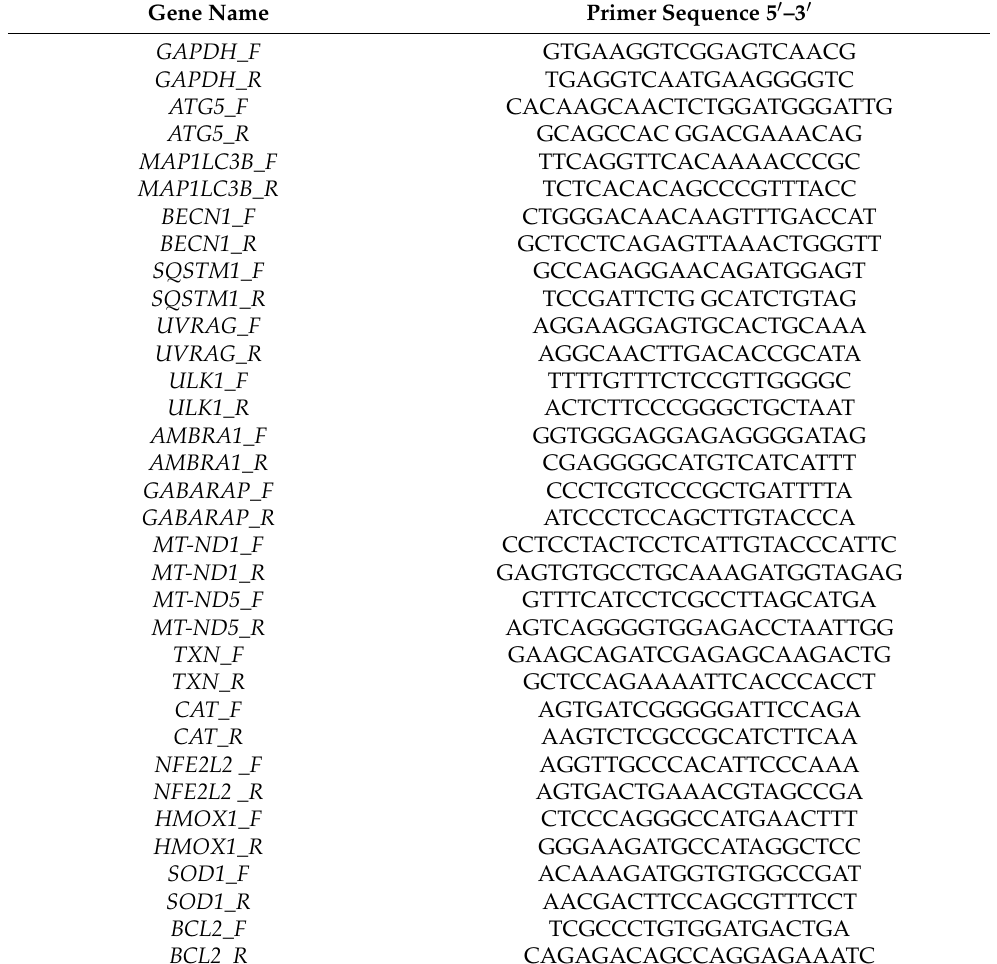
Table 1. List of primers used in this